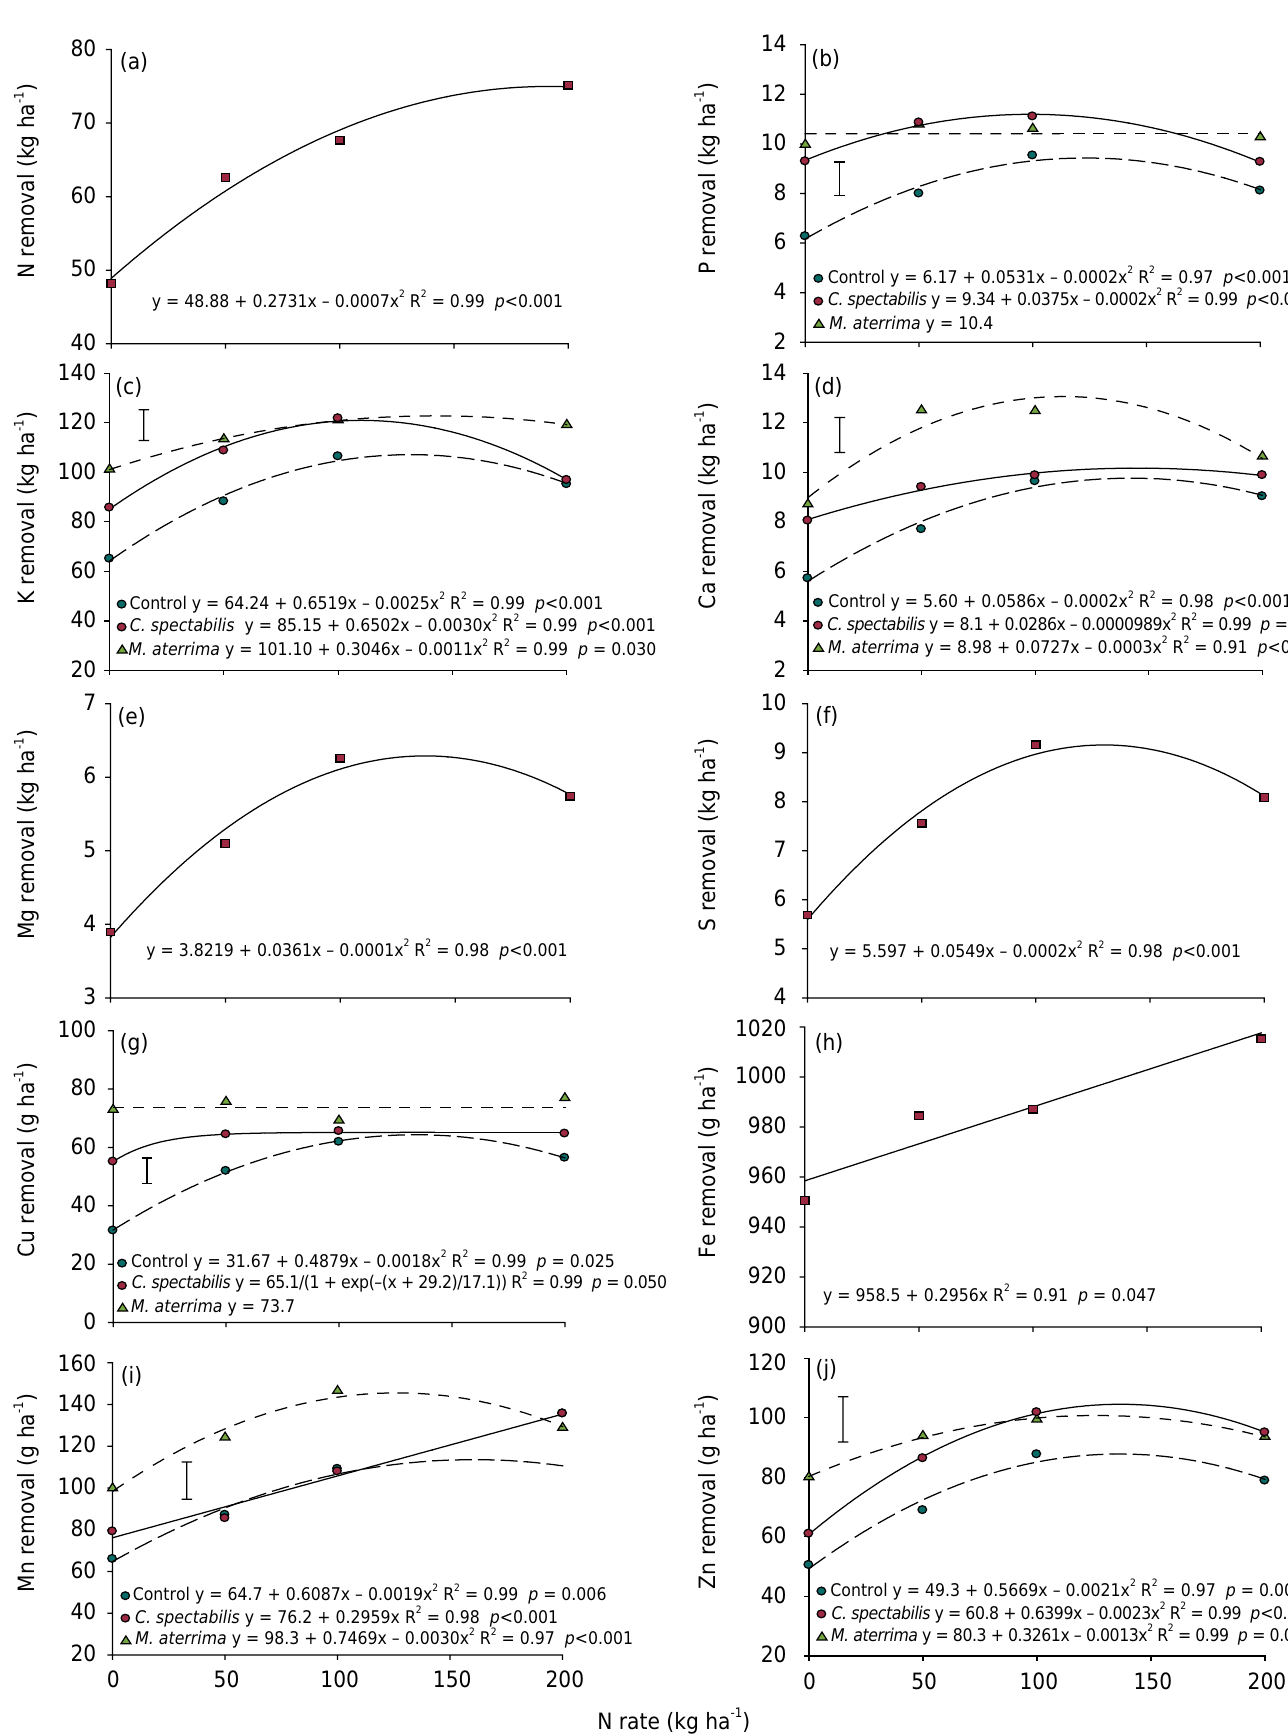
Figure 5. Nutrient removal by sweet potato in response to green manures cultivation and N application rate. Square: mean of the three green manure treatments (Control, C. spectabilis , and M. aterrima ). Vertical bars represent the least significant difference at p≤ 0.05 according to LSD test. Data are the means of the two agricultural